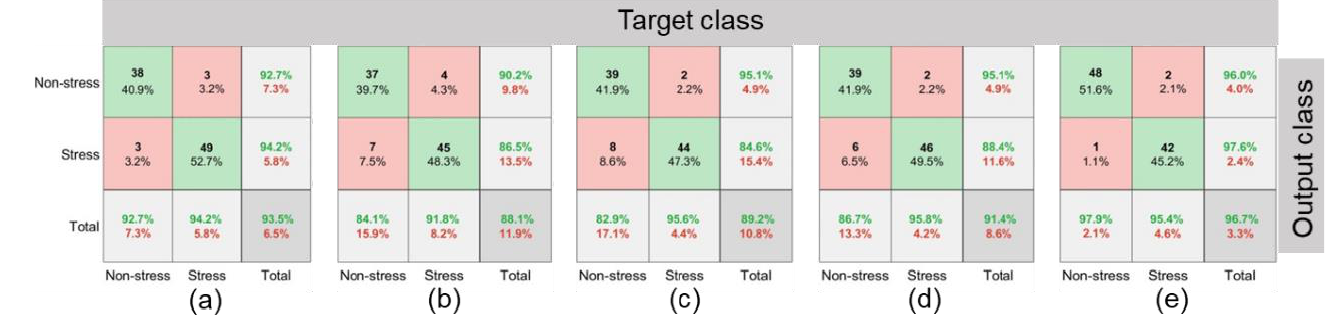
Figure 9. The confusion matrices for function approximation-based ( a ) ANN; ( b ) KNN; ( c ) LR; ( d ) SVM; and ( e ) DL-LSTM models. Cell values (%) in row 1 column 2 represent type 1 error (T E1 ) while those in row 2 column 1 represent type 2 error (T E2 ) (details in Section 2.4). Numbers (% and actual counts) in green color indicate prediction accuracy while those in red color are prediction errors for stressed and non-stressed crop classes. Numbers in green box represent correct prediction and those in red box represent misclassification of non-stressed/stressed classes.